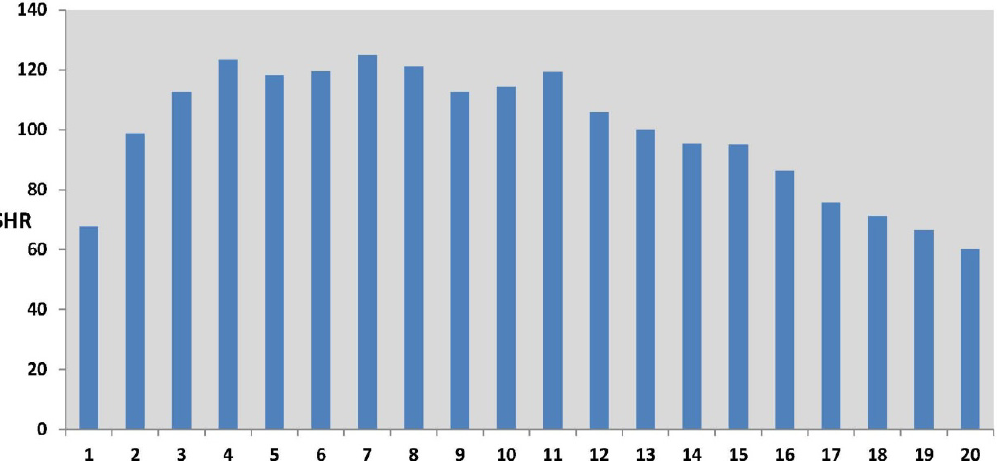
Figure 6. Self-Harm Standard Hospitalisation Ratios (SHRs) by 5-Percentile Rurality Categories (Category 1, lowest rurality, to Category 20, highest rurality).